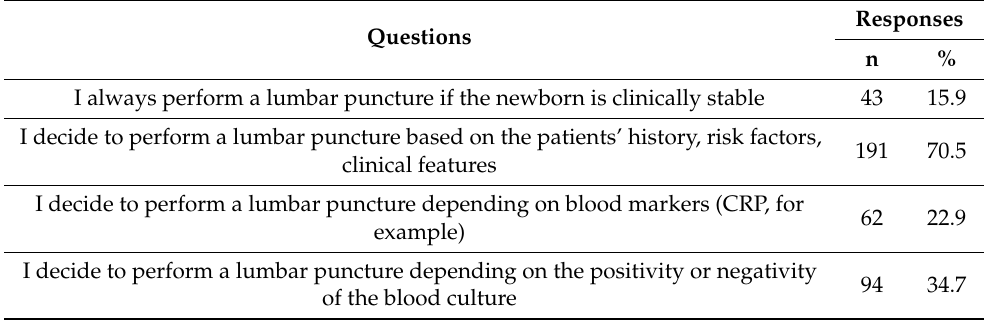
Table 4. Questions about the decision to perform a lumbar puncture and cerebrospinal fluid